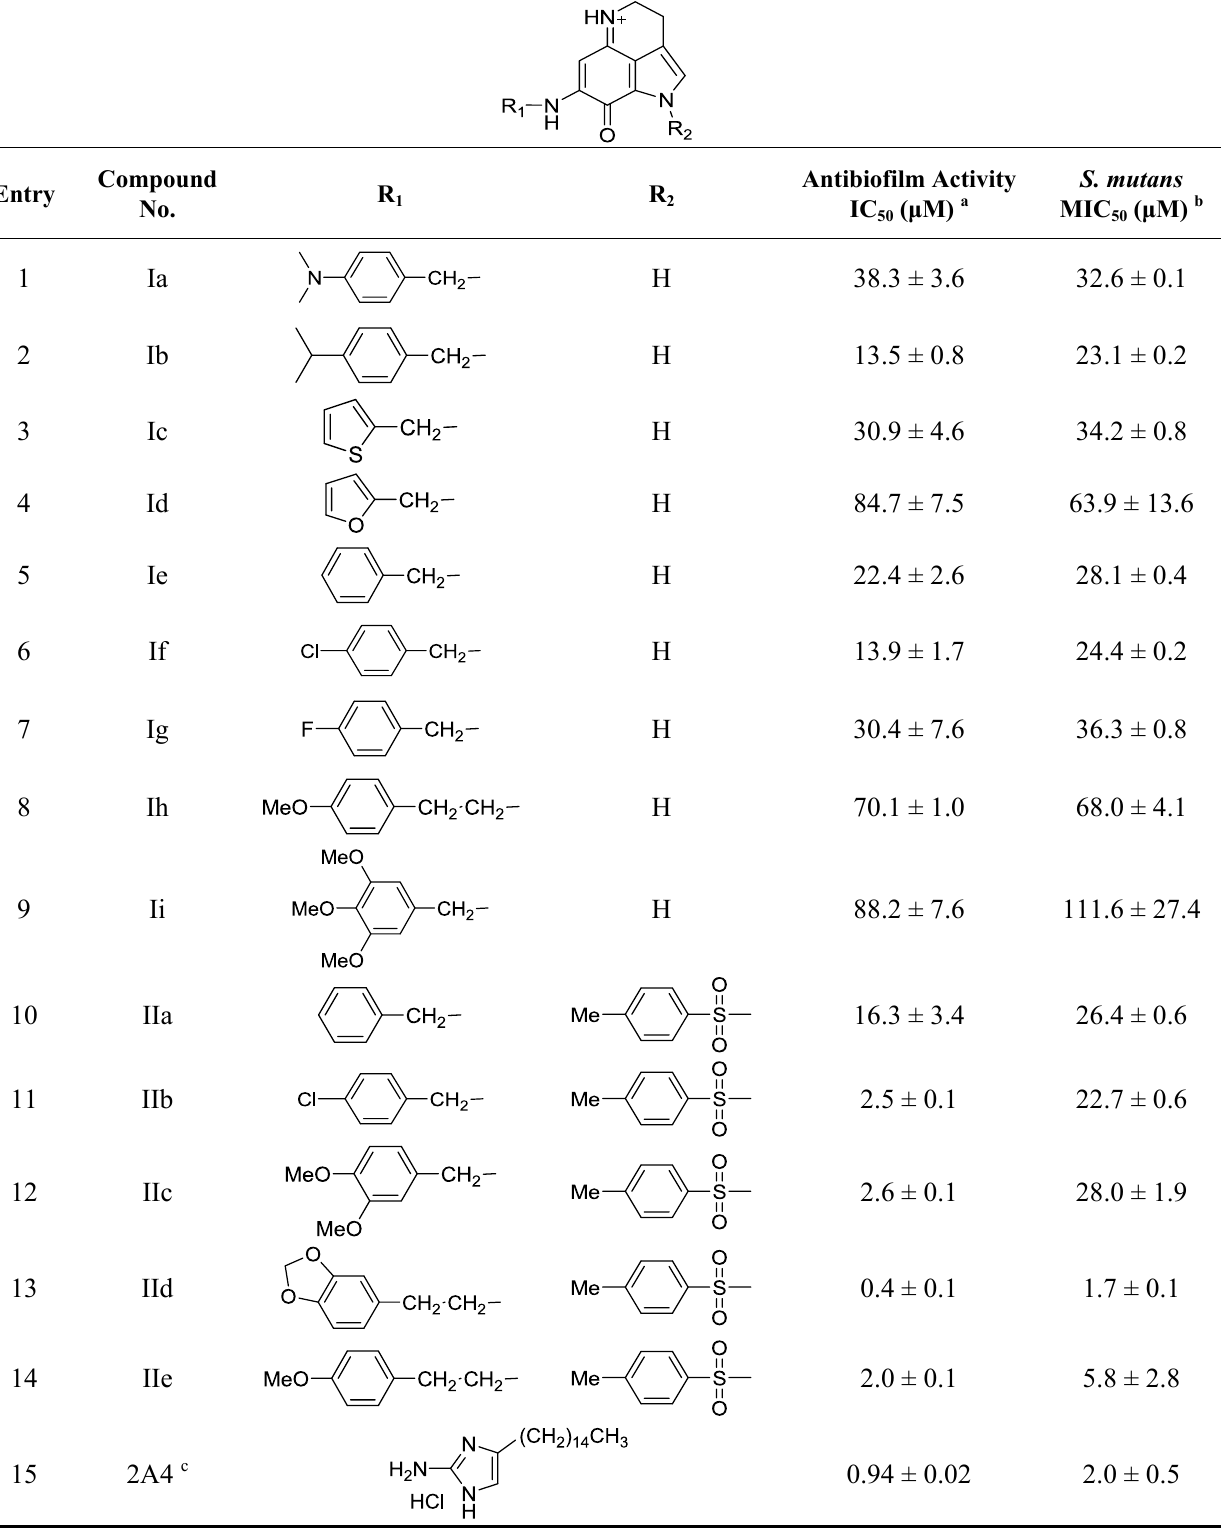
Table 1. Antibiofilm activity and antibacterial activity of makaluvamine analogs against S. mutans